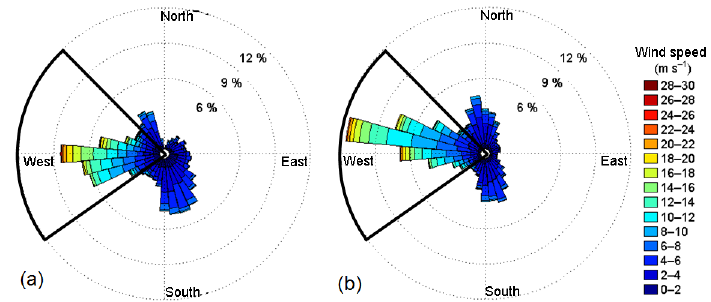
Figure 4. Wind roses for (a) lidar 80m altitude and (b) met tower 87m altitude, the closest to hub-height with both a cup and vane. Wind speed bins are 2ms − 1 and wind directions bins are 10 ◦ . The black outline highlights the chosen wind direction sector.